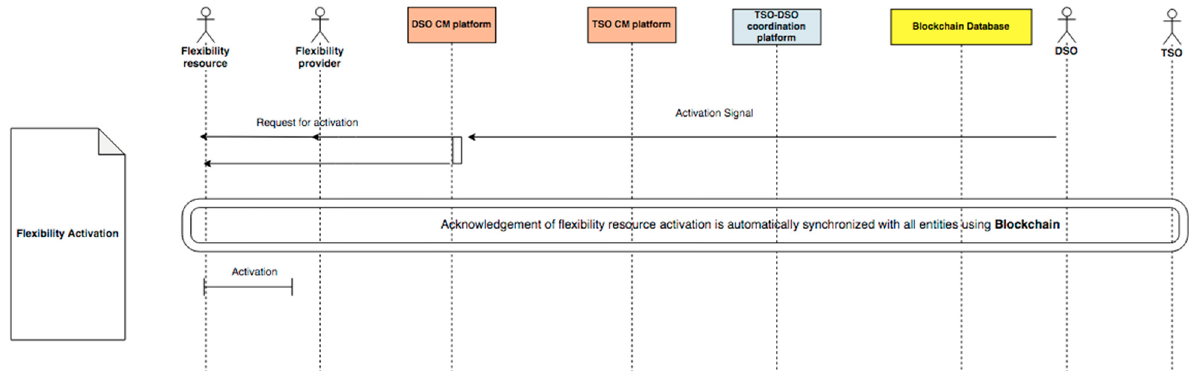
Figure 14. Flexibility Activation.